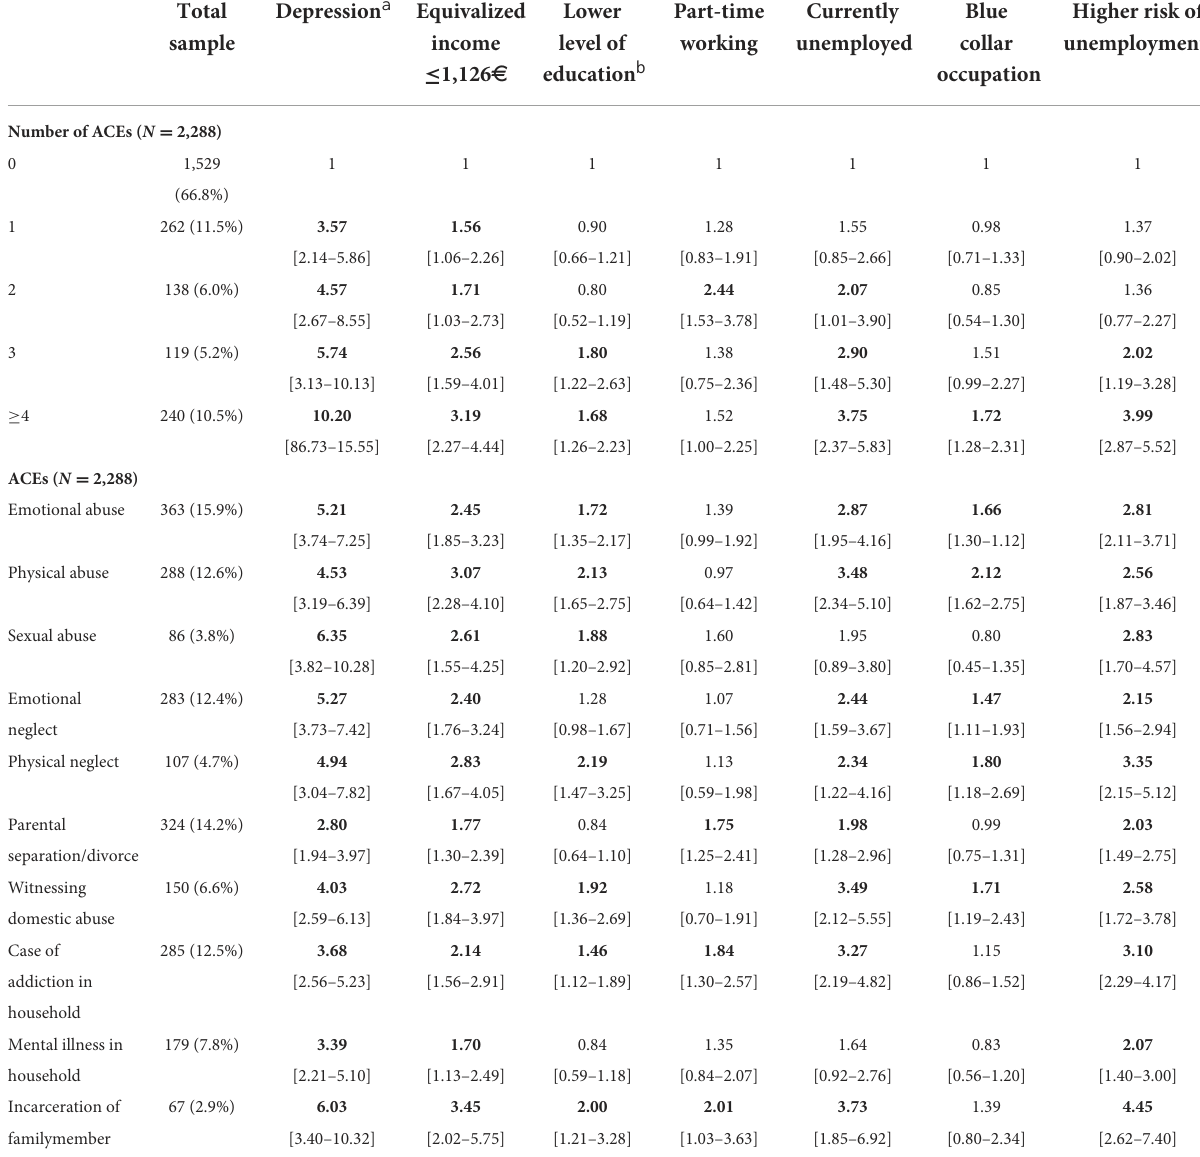
TABLE 2 Prevalence of combined adverse childhood experiences (ACEs), odds ratios and 95% confidence intervals for depression, income, education, working hours, occupation, and risk of unemployment. Total